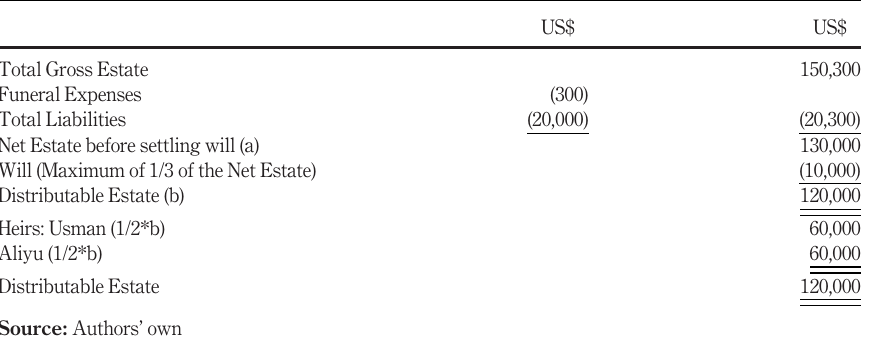
Table II. An example of